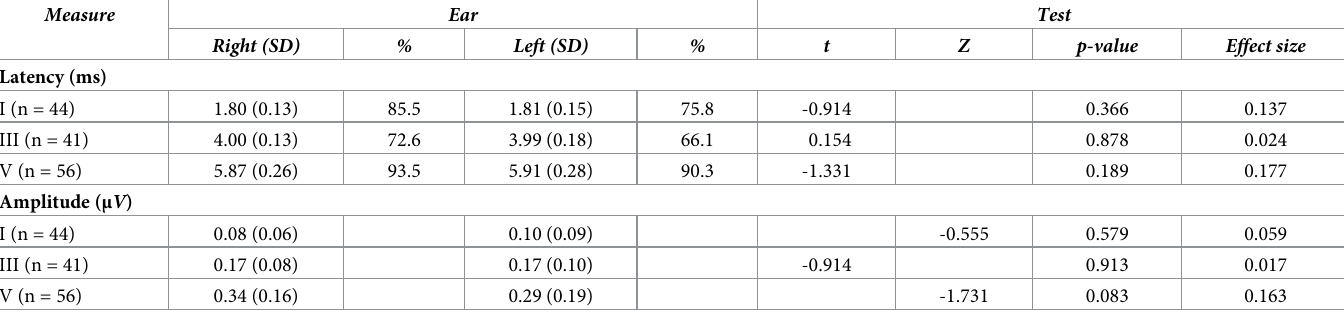
ear. Finally, for the FFR components D, E, and F, detectability varied between 98.4 and 100% in the right ear and between 93.5 and 100% in the left ear. Grand average speech-ABR wave- forms for right and left ear presentations are shown in Fig 3. Right and left ear differences for peak latencies and amplitudes. Latency and amplitude values for all the main speech-ABR peaks using the 40-ms /da/ syllable for the right and left ears are displayed in Table 2. Note that ear comparisons were carried out using only the data from those participants whose speech-ABR latencies and amplitudes were identified in both the right and the left ears. Significant ear differences in latency were found for the onset peak V ( t = -2.674; p = 0.010; d = 0.367), peak A ( t = -3.258; p = 0.002; d = 0.443), and offset peak 52 53 O ( t = -4.326; p < 0.001; d = 0.549). Latency for all transient peaks (V, A, and O) in the right 61 ear were significantly shorter than in the left ear. With regard to peak C, the right ear showed a significantly shorter latency than the left ear ( t = -2.649; p = 0.012; d = 0.418). Regarding the 39 FFR components, right ear latencies were also significantly shorter than those for the left ear Table 1. Mean and standard deviation (SD) of the latency (after stimulus onset) and amplitude values of the click-ABR components for the right and left ears for the group of participants. Measure Ear Test Right (SD) % Left (SD) % Effect